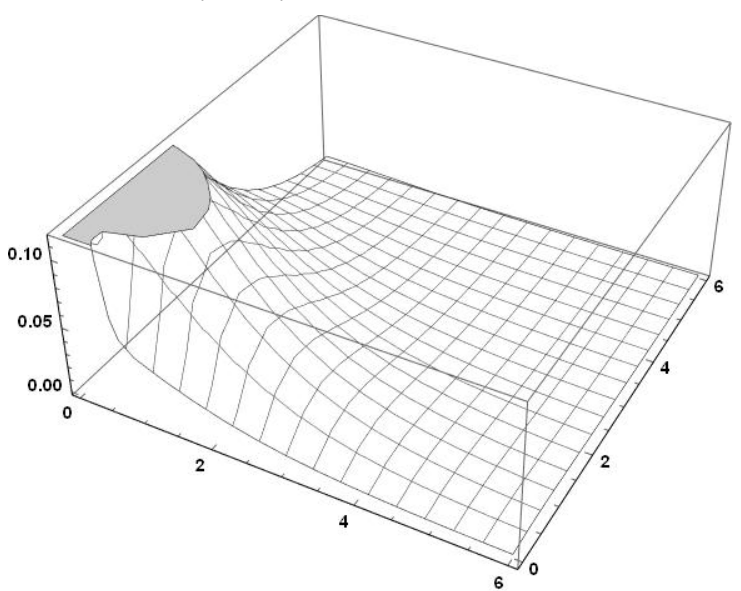
Figure 2. Joint Probability Density Function of MAP − PC